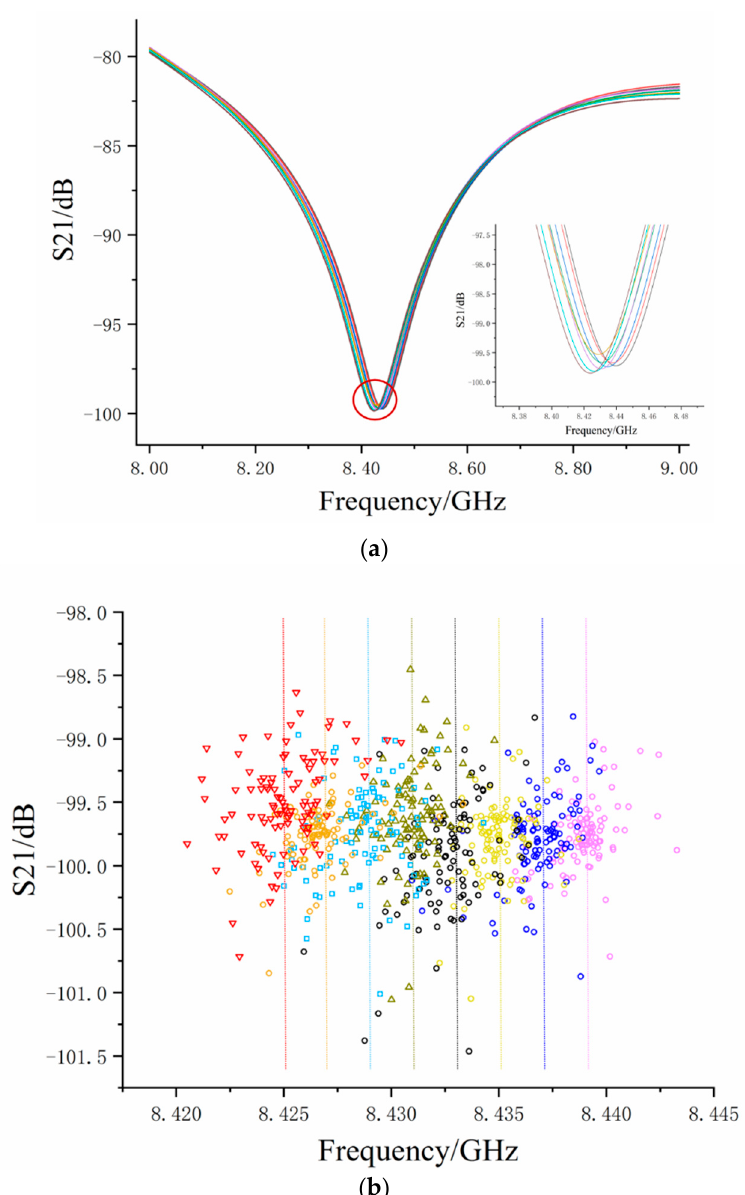
Figure 6. ( a ) The frequency shift of the microwave interference signal under strain changes. ( b ) Coordinates of S-parameter valley point of measured data.